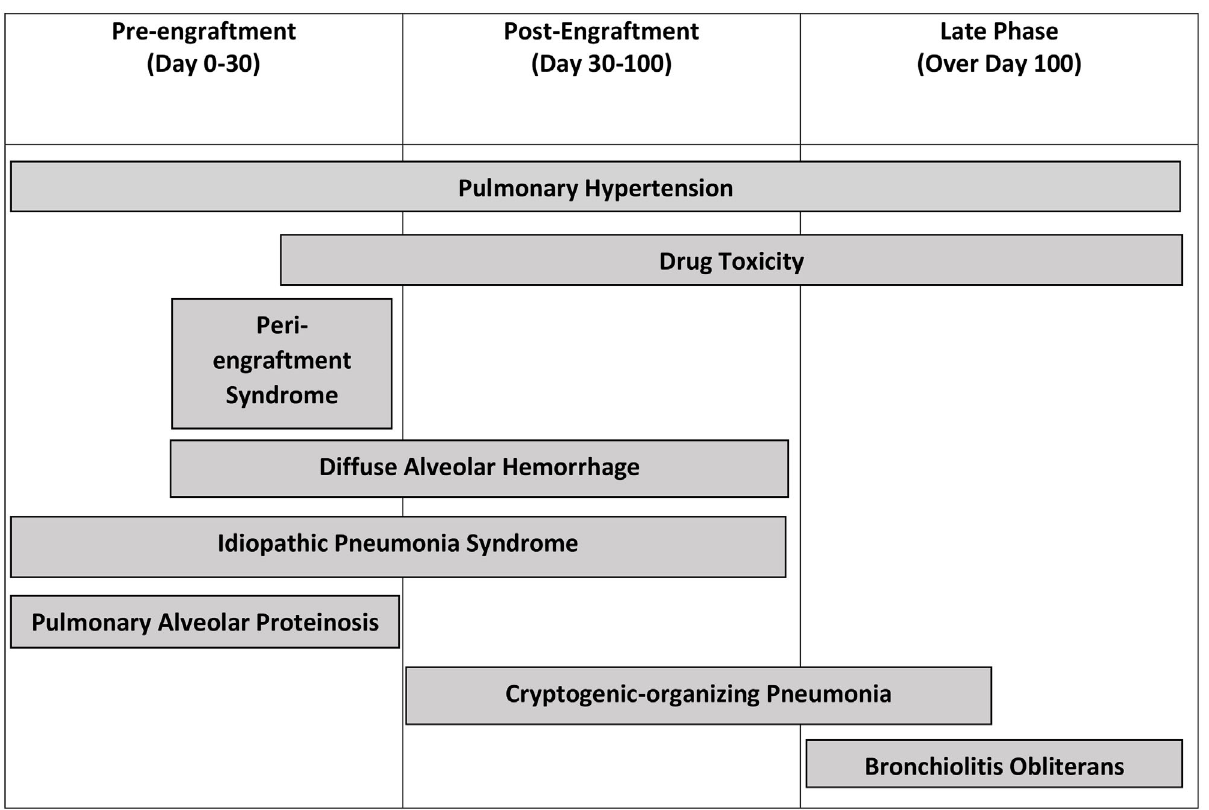
TABLE 5 | Non-infectious complications and the most common times in which